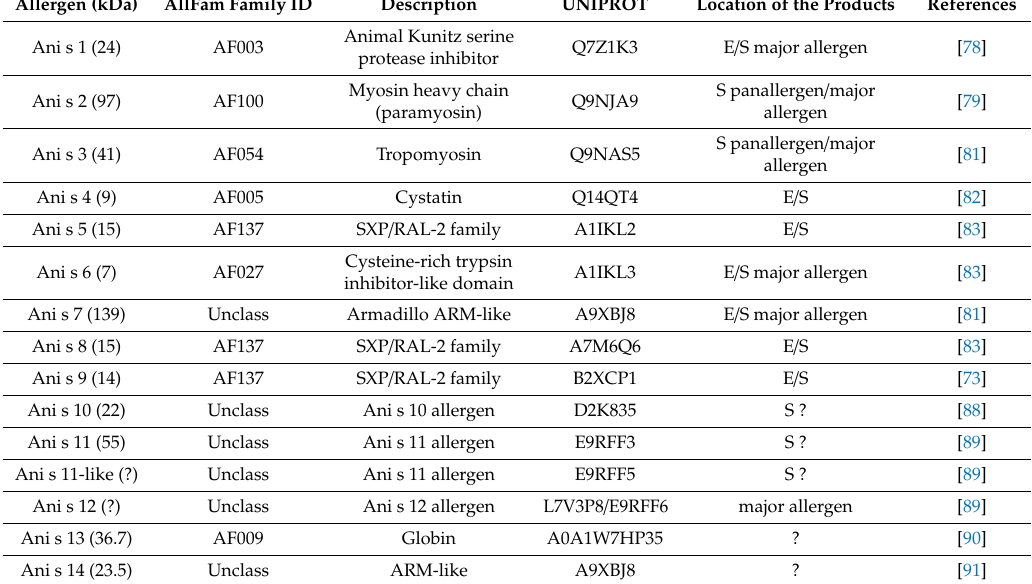
Table 1. List of identified Anisakis simplex allergens, with indications of codes according to the allergen database (AllFam), the UniProt database, and the nature of protein (E / S: excreted / secreted; S: somatic), along with references to the